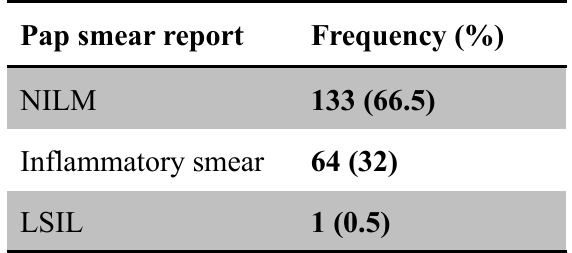
Table 2: Distribution of the study participants based on their gestational age (N=200)